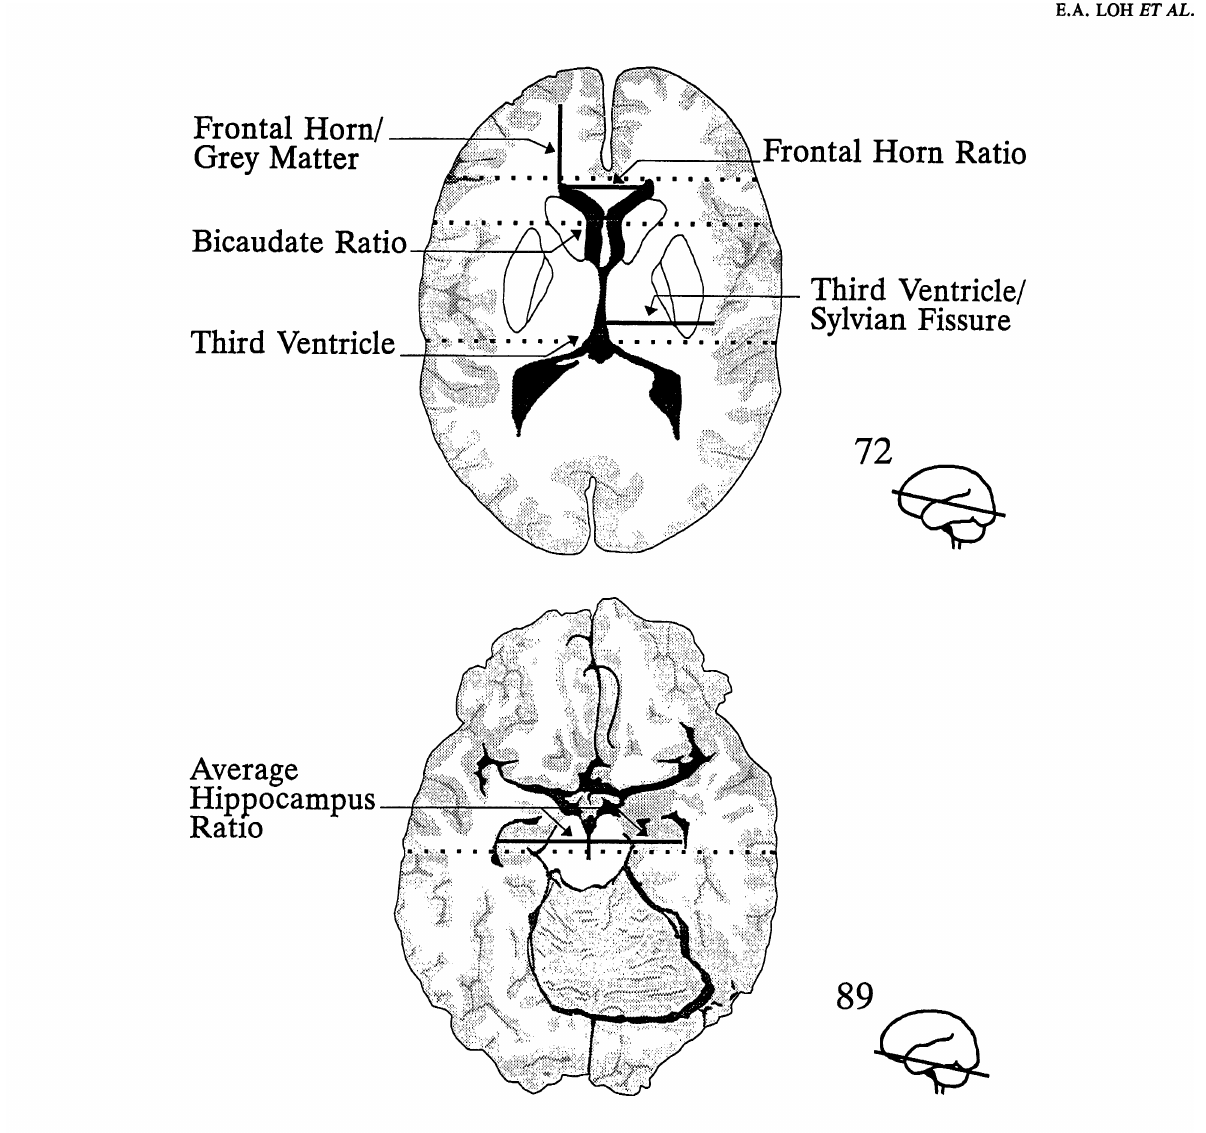
FIG. 1. Neuroanatomical measures used. FHit is the distance between the internal tables of the skull on a line drawn through the tips of the frontal horns. FH is the maximal distance between the tips of the frontal horns. Frontal horn ratio (FHr) is determined by dividing FH by FHit. CCit is the distance between the internal tables of the skull taken at the point at which the medial edges of the caudate nuclei are closest. CC is the minimal distance between the caudate nuclei. Bicaudate ratio (CCr) is CC divided by CCit. 3V is the measure of the maximum width of the third ventrical. Third ventricle ratio (3Vr) is 3V divided by CCit. LENTI is the distance between the edge of the third ventricle at its widest point and the outer edge of insular cortex. Both the left and right LENTI measures are combined, and t,he sum is taken to produce a single value. Lentiform ratio (LENTlr) is LENTI divided by